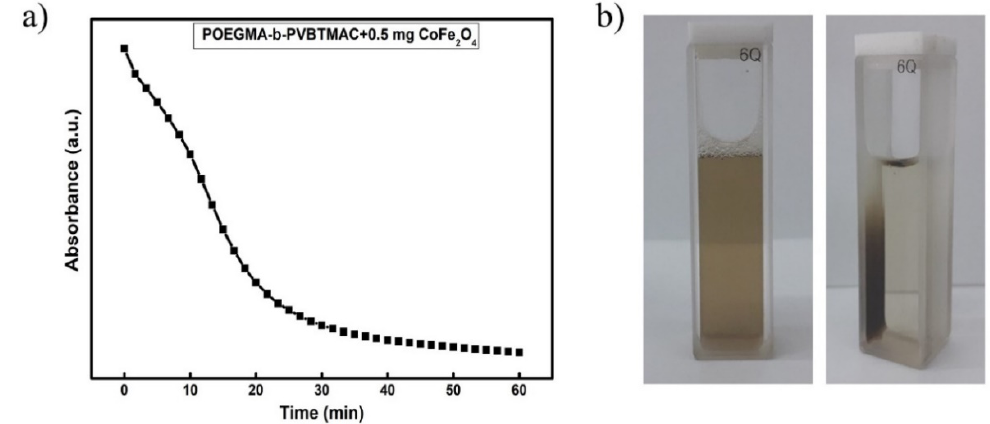
Figure 8. ( a ) Magnetophoresis plot showing absorbance as a function of time for MNPs-hybrid complexes ( λ = 450 nm), ( b ) MNPs-hybrid complexes before and after the application of external magnetic field (using a magnet) for the magnetophoresis experiments.